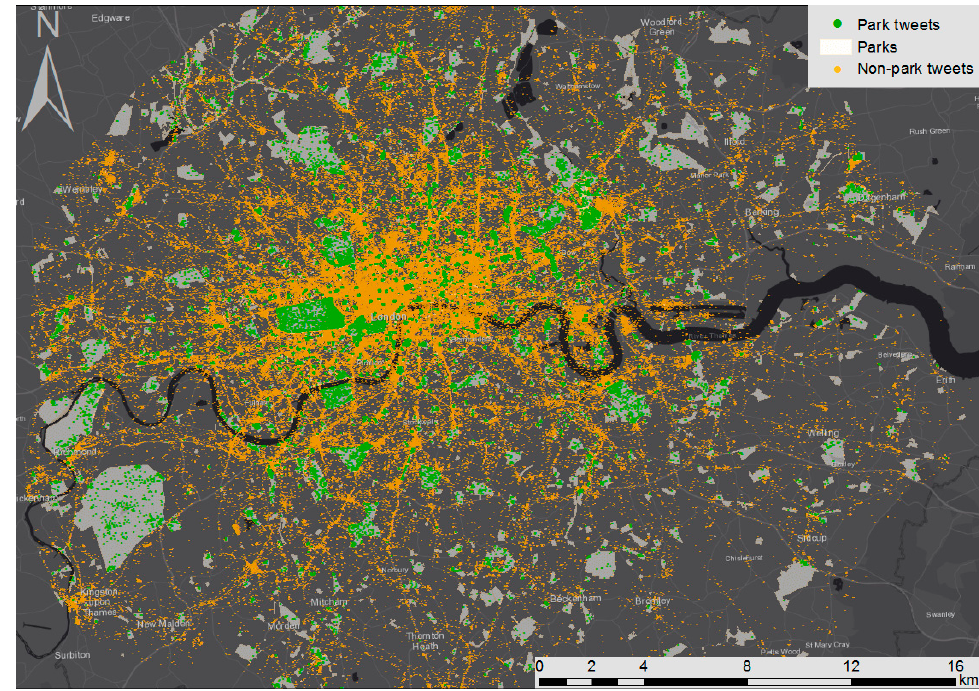
Figure 3. Map of tweets and parks (input data sets of the analysis).